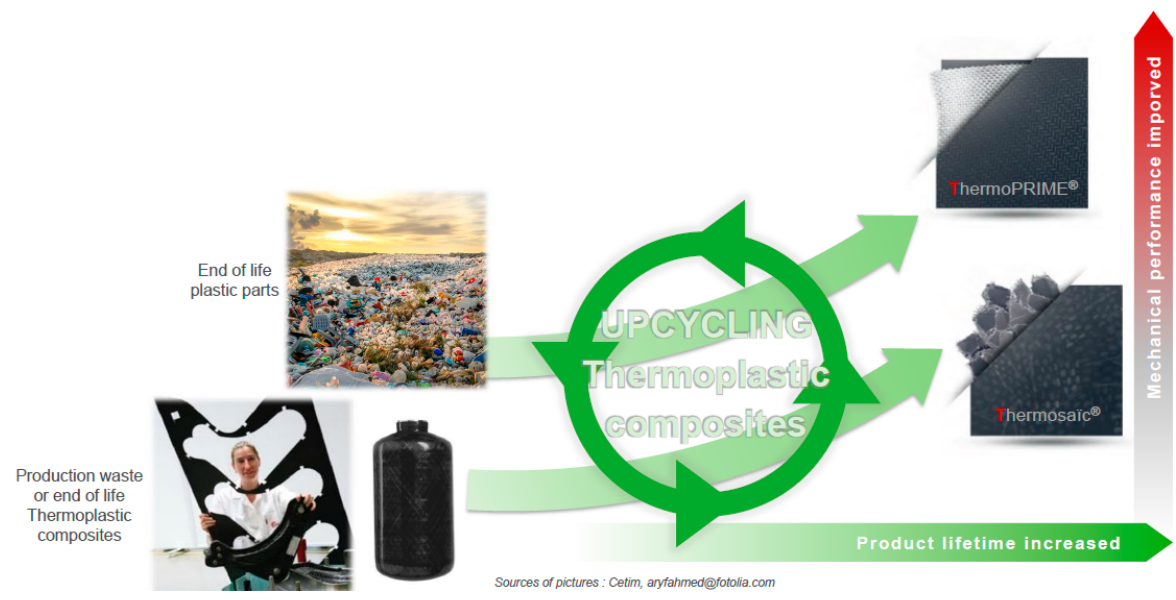
Figure 15. Thermosaïc ® Technology to recycle end-of-life tanks [75].